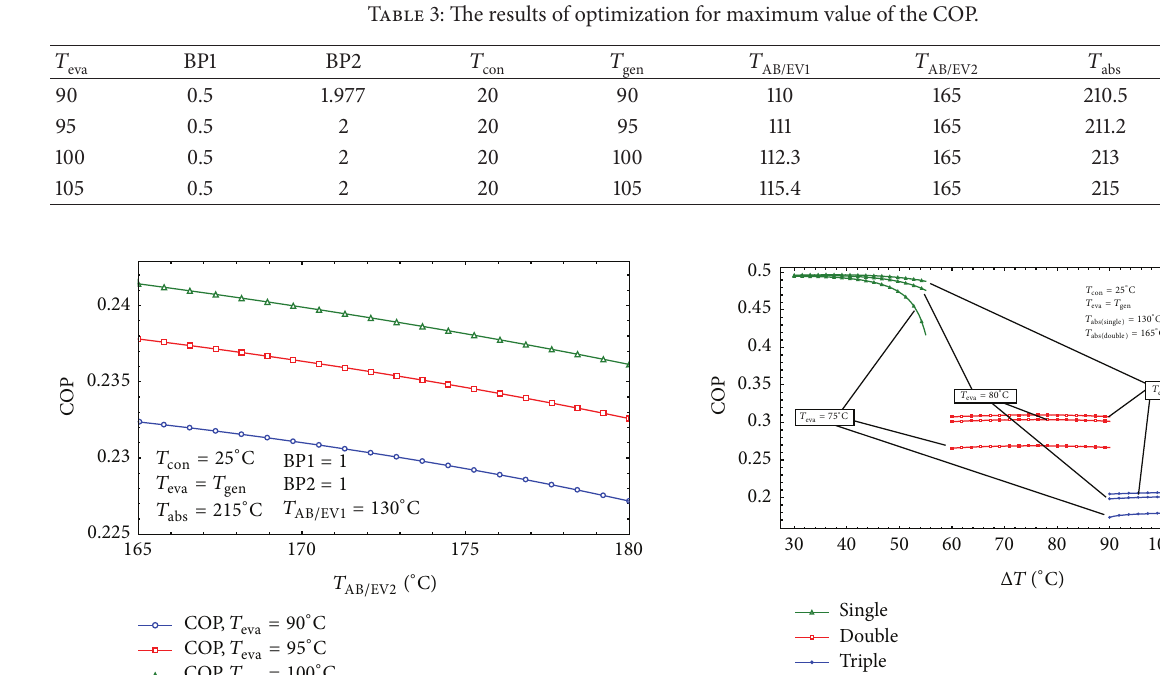
Figure 14: The effect of 𝑇 on COP of the system. AB / EV 2